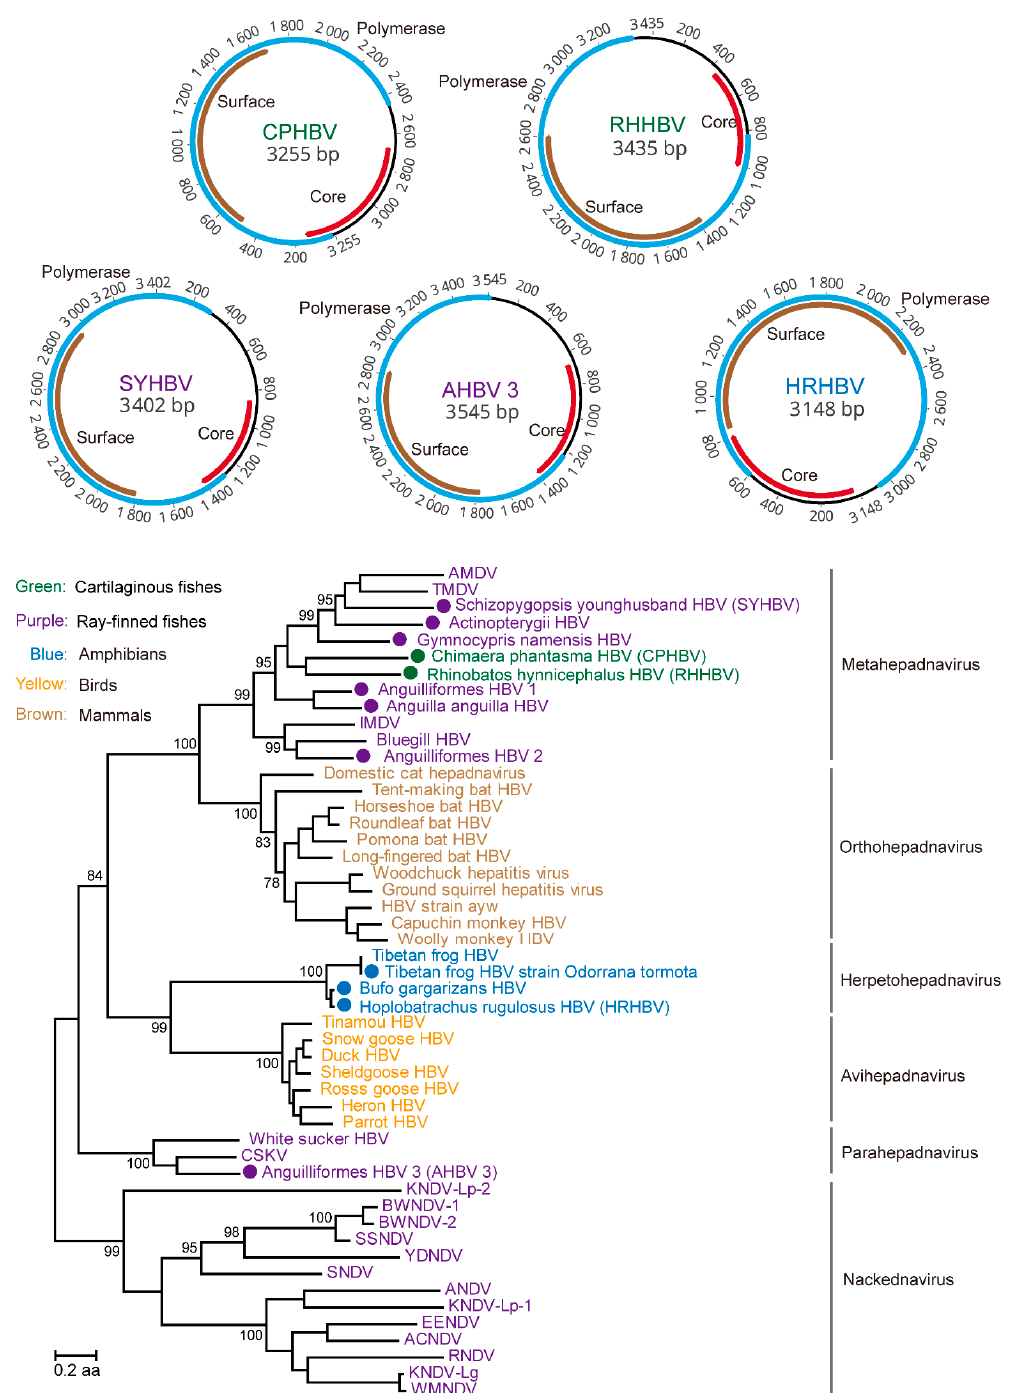
Figure 4. Genome organization and evolutionary analyses of hepadnaviruses discovered from metatranscriptomics and transcriptomics data. Upper panel: Genome structures of five complete hepadnavirus genomes, including Rhinobatos hynni- cephalus HBV (RHHBV), Chimaera phantasma HBV (CPHBV), Anguilliformes HBV 3 (AHBV 3), Schizopygopsis